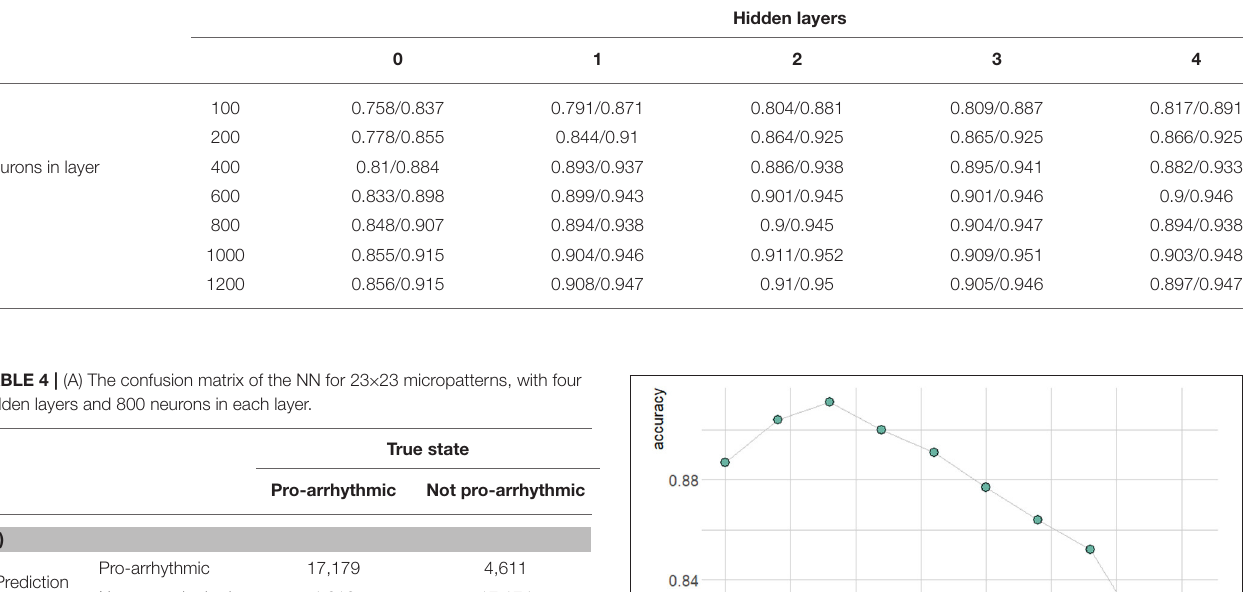
TABLE 3 | The resulting accuracy/area under the curve (AUC) of the neural network (NN) for the size of the micropattern 9.